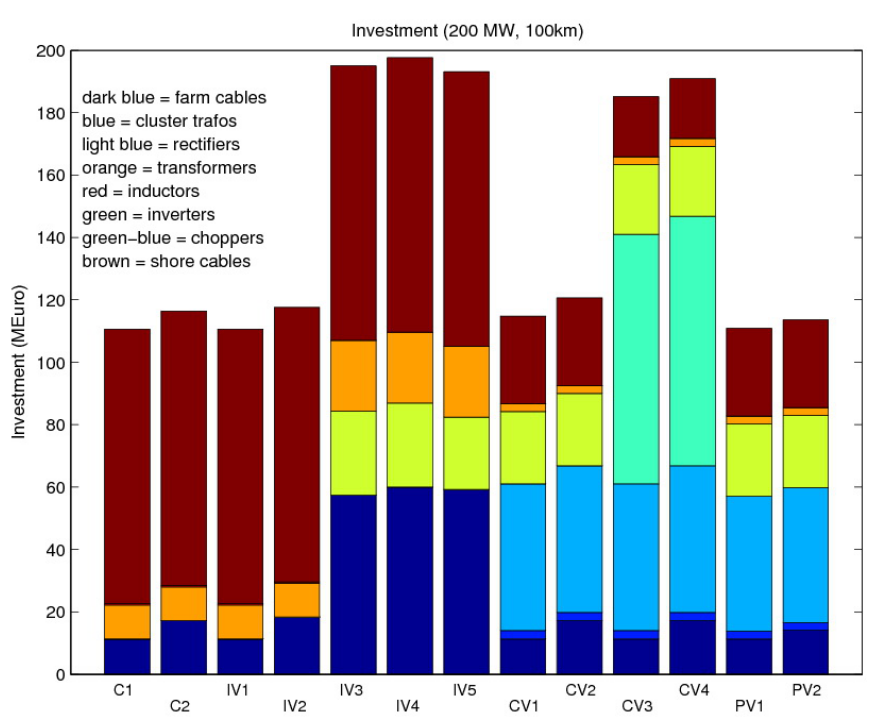
Figure 12 . Investment costs (200 MW, 100